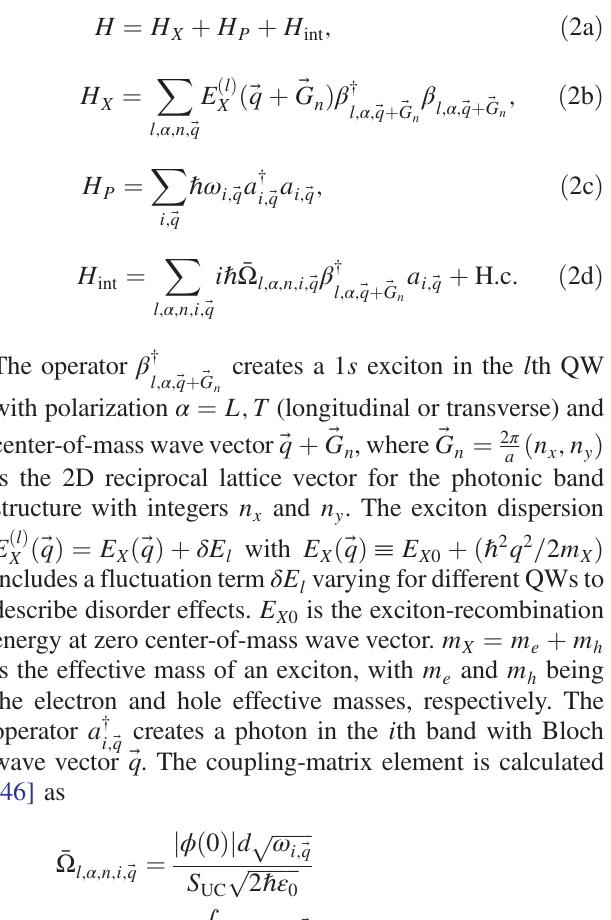
≤ q ; q < π . The x y a a